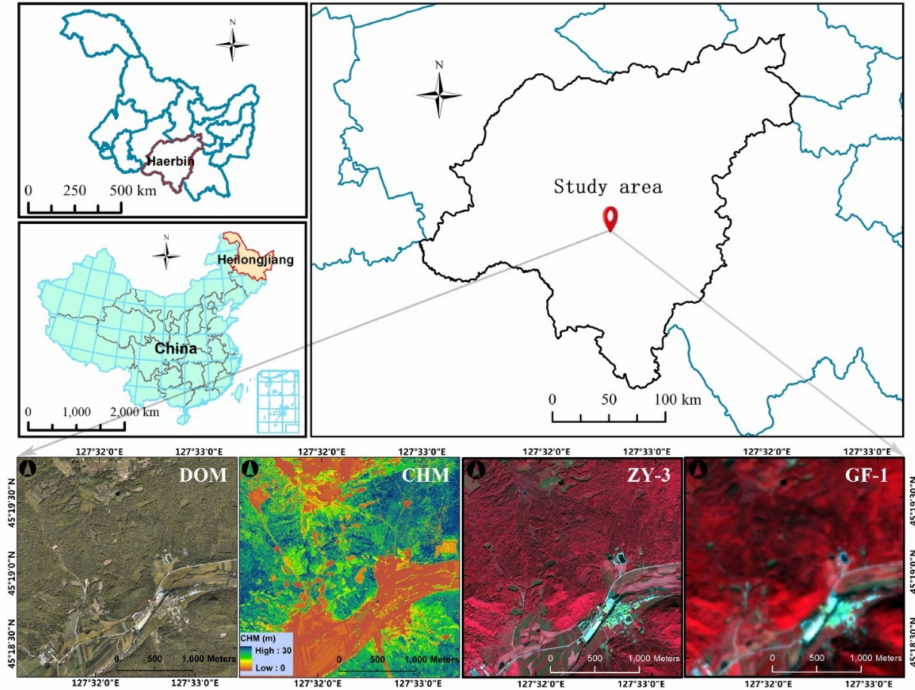
Figure 1. Location of the research area and multi-source remote sensing dataset (aerial orthophoto, LiDAR, ZY-3 and GF-1